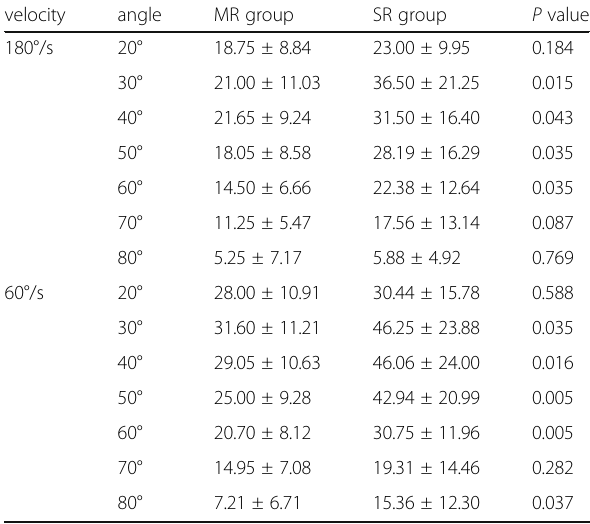
Table 5 Angle-specific flexion torque (mean ± SD) at 180°/s and 60°/s